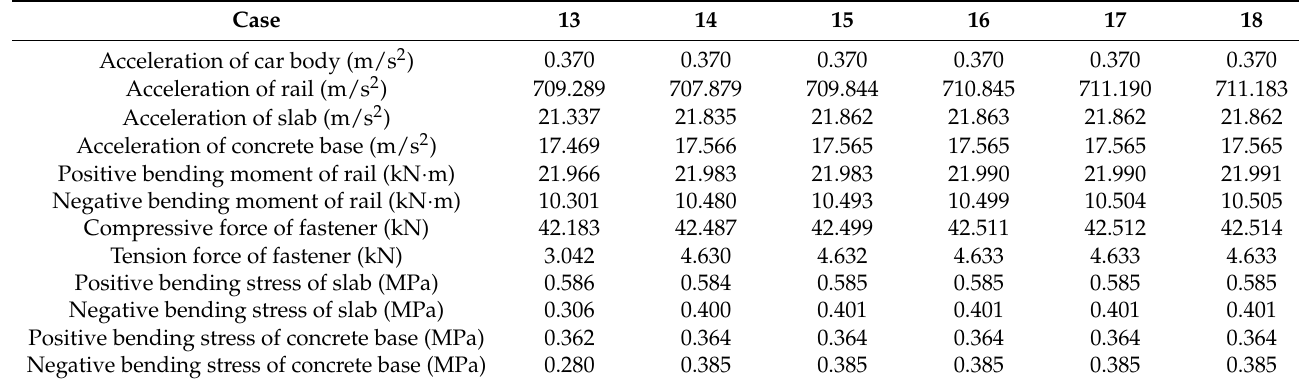
Table 7. Largest dynamic responses for Cases